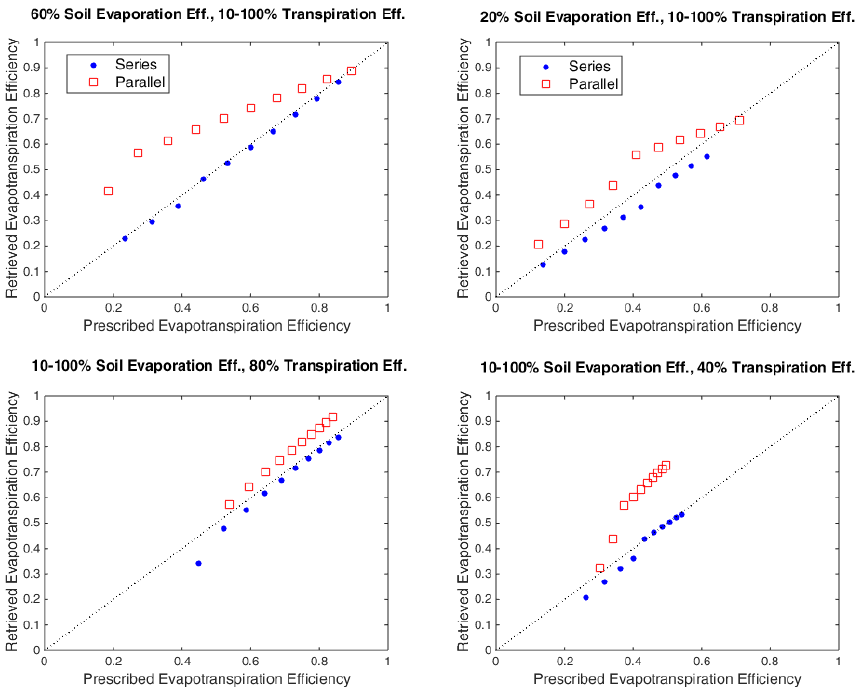
Figure 3. Retrieval test for total evapotranspiration ( β ) efficiency when using T rad values as input to SPARSE for given combinations of prescribed β s and βv values.